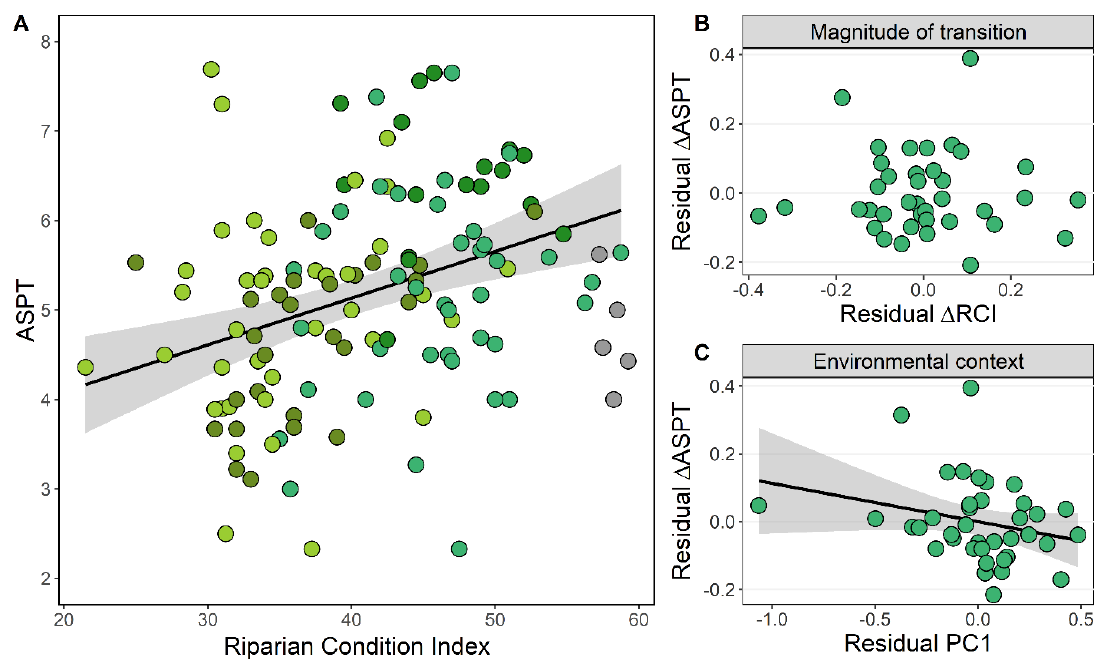
Figure 6. Plot A shows the association of the Riparian Condition Index with a commonly used stream macroinvertebrate indicator, the Average Score Per Taxon (ASPT) index. Outlier sites in grey indicate “reference” forested sites in Sweden which went dry in the summer prior to macroinvertebrate sampling, potentially explaining lower than expected values for the ASPT. Plots B and C show the individual strength of the riparian “magnitude of transition” and the “environmental context” hypotheses after accounting for other influences across our four case-study basins. These analyses use the log response ratio for the Average Score Per Taxon index score at paired sites as the response variable ( ∆ ASPT). The riparian “magnitude of transition” predictor uses the log response ratio for the Riparian Condition Index at paired sites ( ∆ RCI). The “environment context” predictor (PC1) is the Axis 1 sites scores from a PCA explaining 37% variation in catchment-wide human impacts (i.e., indicating the level of upstream degradation). See Table 4 for results from mixed models testing these responses.